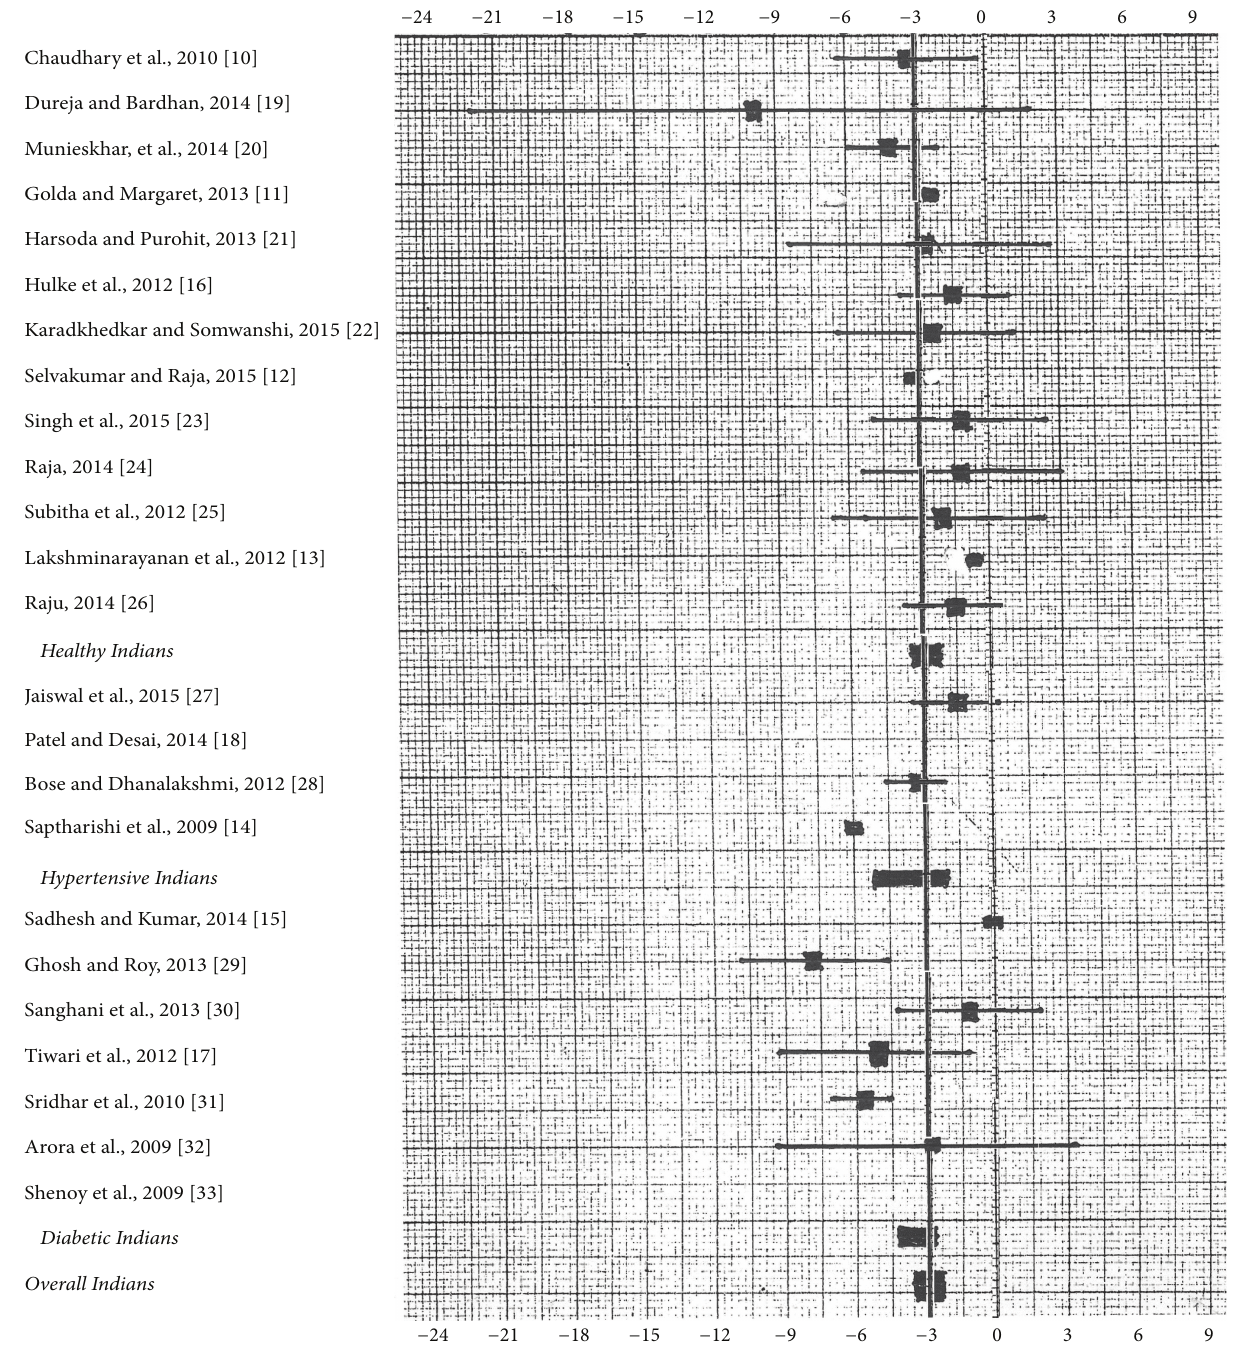
Figure 2: Summary of aerobic training on DBP (mean difference with 95% CI) in Indians. Bold vertical line is meta-analysis mean ( 𝑛 = 23 ).